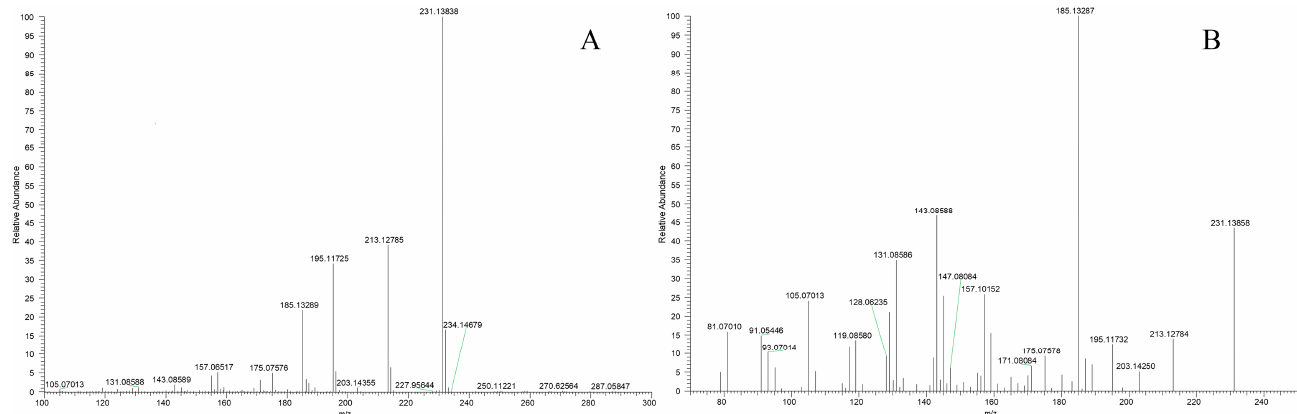
Figure 3. ESI–MS n spectra of DL in the positive ion mode: ( A ) MS 1 spectrum; ( B ) MS 2 spectrum.